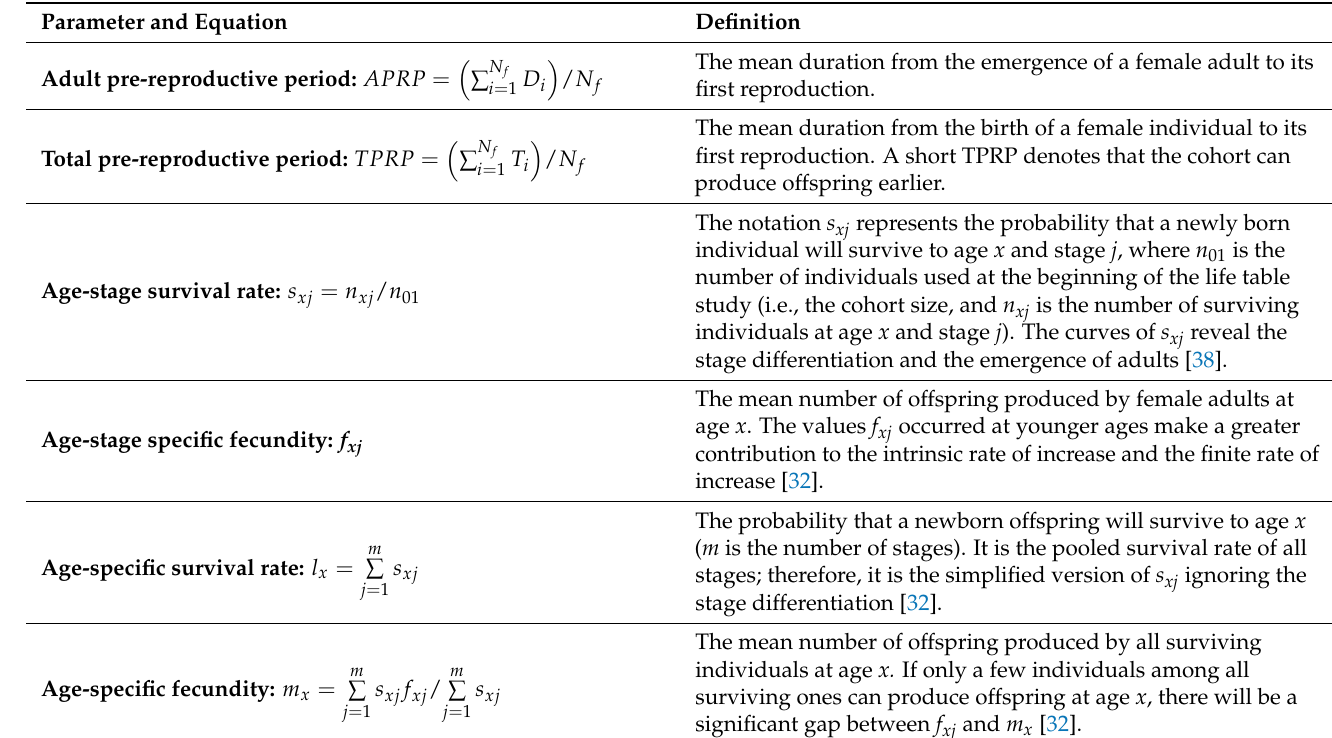
Table 1. The population parameters, their definitions, and the equations used in their calculations. Parameter and Equation